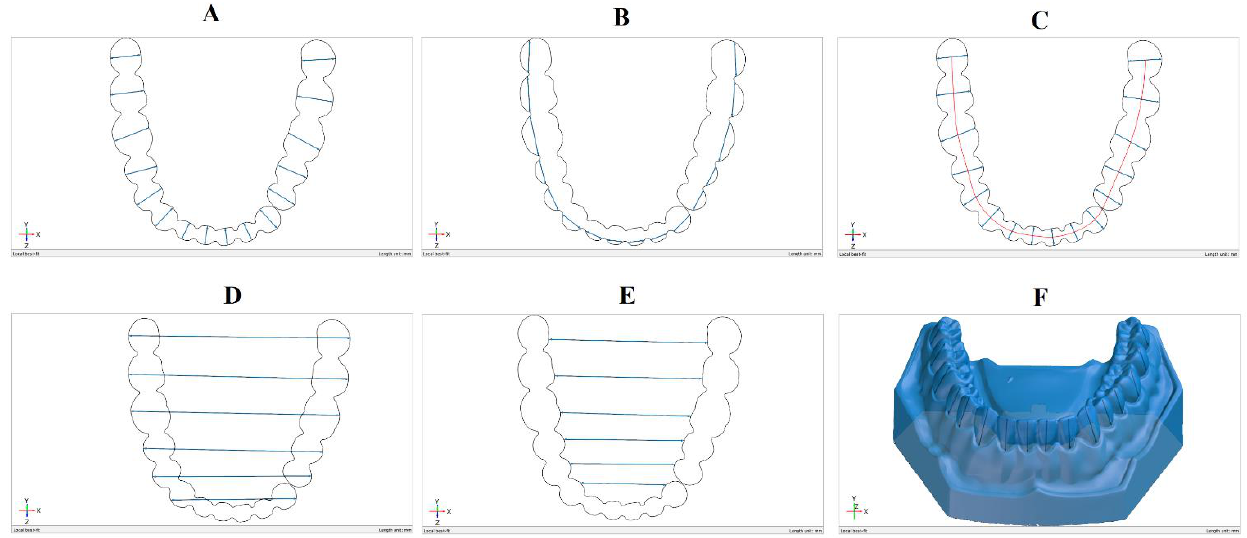
Figure 4. Measurements done on the models: ( A ) The buccolingual width, ( B ) the mesiodistal width, ( C ) the arch curve length, ( D ) arch width (exterior), ( E ) arch width (interior).( F ) 3D printed model surface